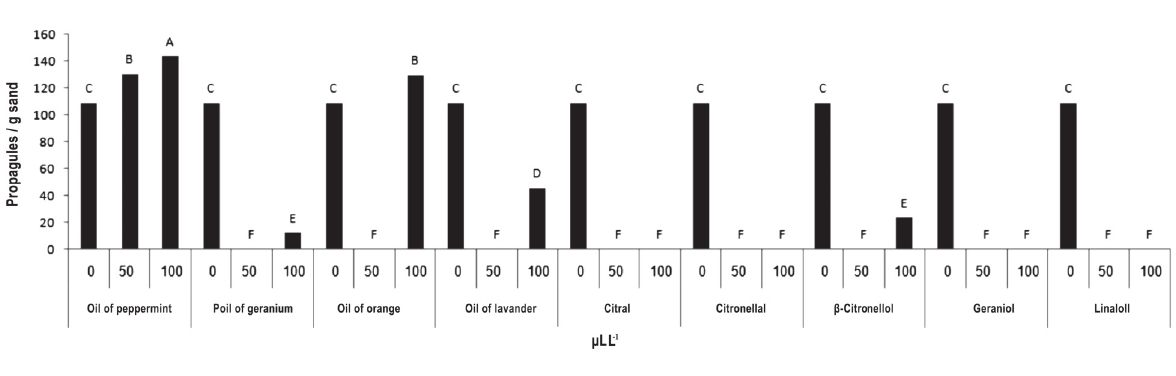
Figure 5. Mean numbers of propagules of Fusarium oxysporum f. sp. sesame in sand (fumigant effect) after exposure to different essential oils. Bars followed by the same letter are not signi fi cantly different ( P ≤ 0.01%), Duncan’s Mul- tiple Range